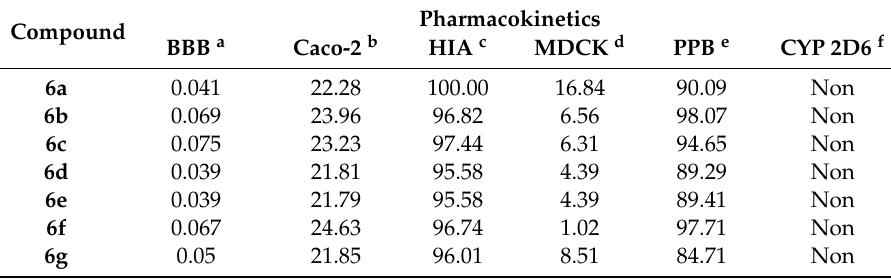
Table 7. ADME data of tested compounds calculated using preADMET